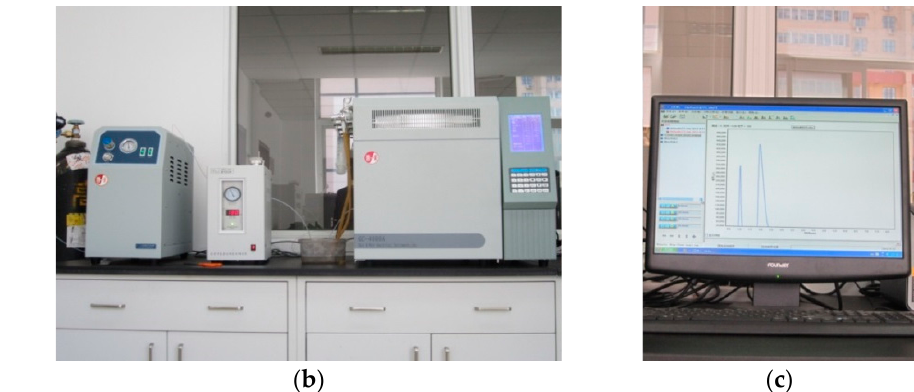
Figure 8. Test setup of the coal SC marker gas. ( a ) Temperature-programmed furnace, ( b ) gas chromatograph, ( c ) analysis software.